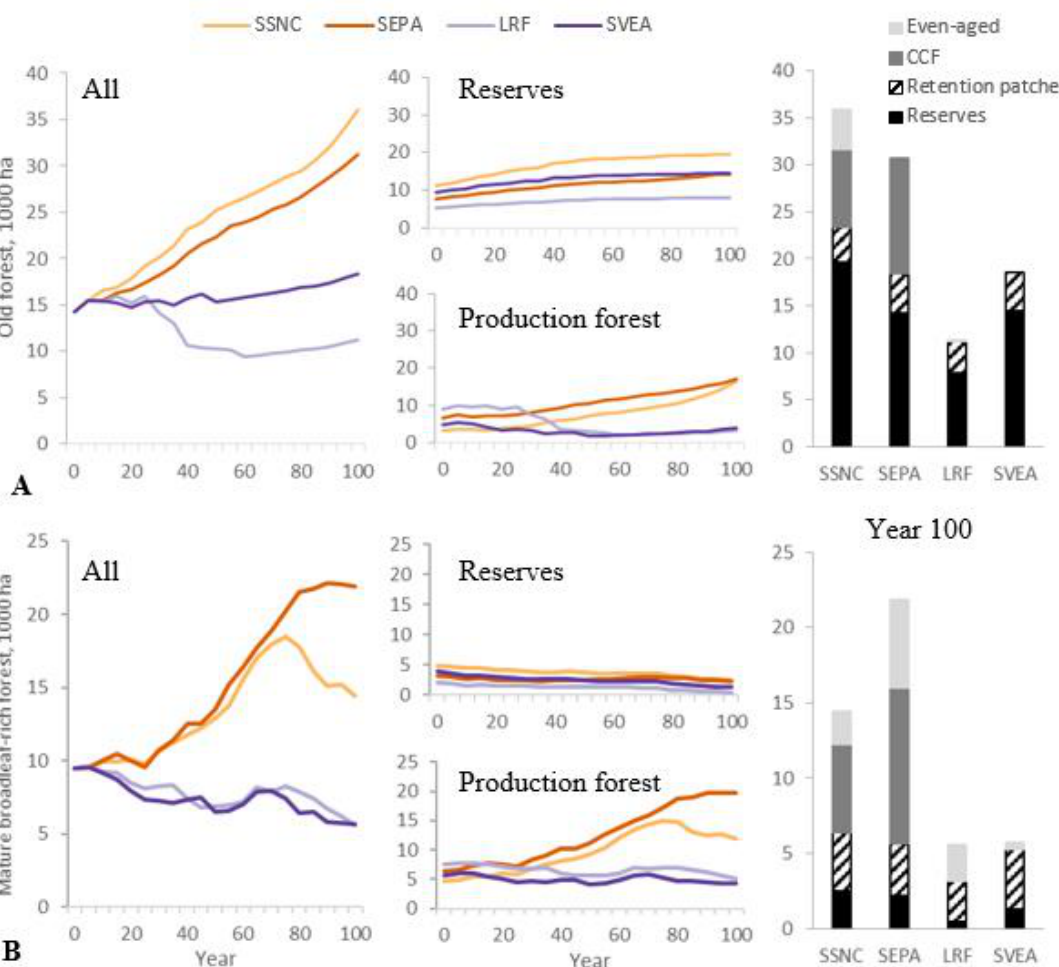
Figure 5. Area of old forest (age ≥ 140 years, A ) and mature broadleaf-rich forest ( B ) in the four stakeholder scenarios; development over time in all forest (left), reserves and production forest (middle), and after 100 years under different management regimes (right).